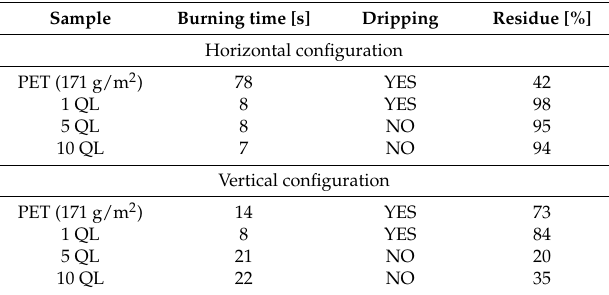
Table 12. Combustion data of untreated and QL-treated PET by horizontal and vertical flame spread tests [29].